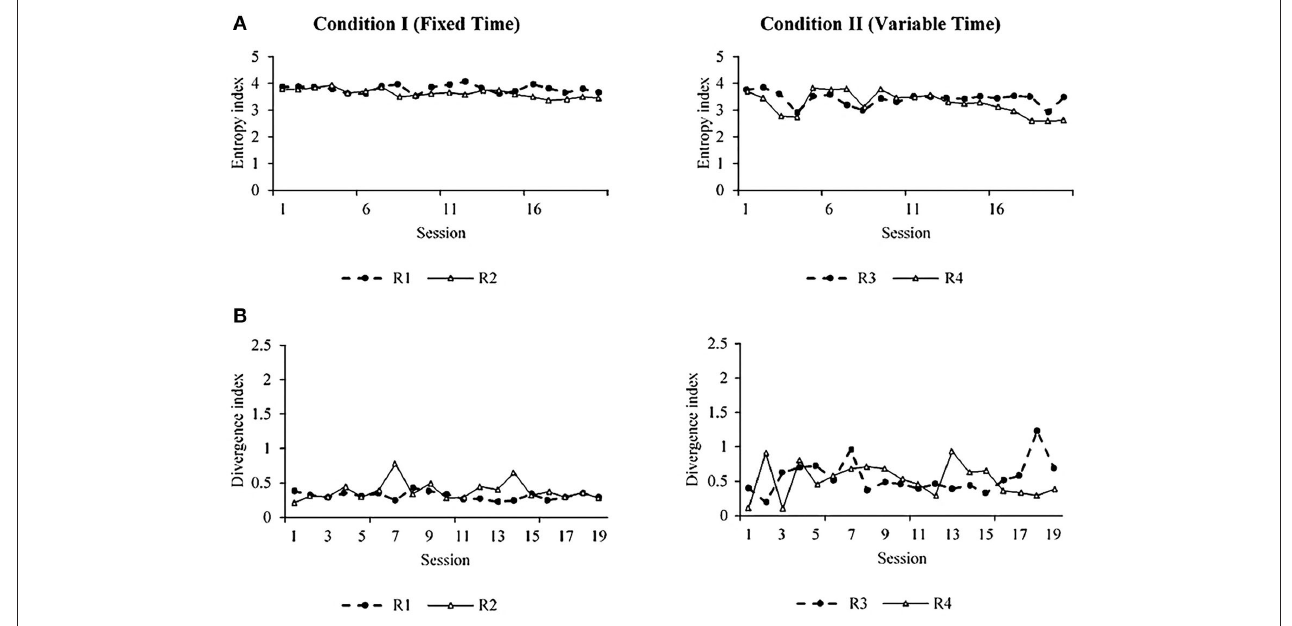
FIGURE 3 | Entropy (A) and divergence (B) measures for subjects R1 and R2 under FT schedules (left) and subjects R3 and R4 under VT